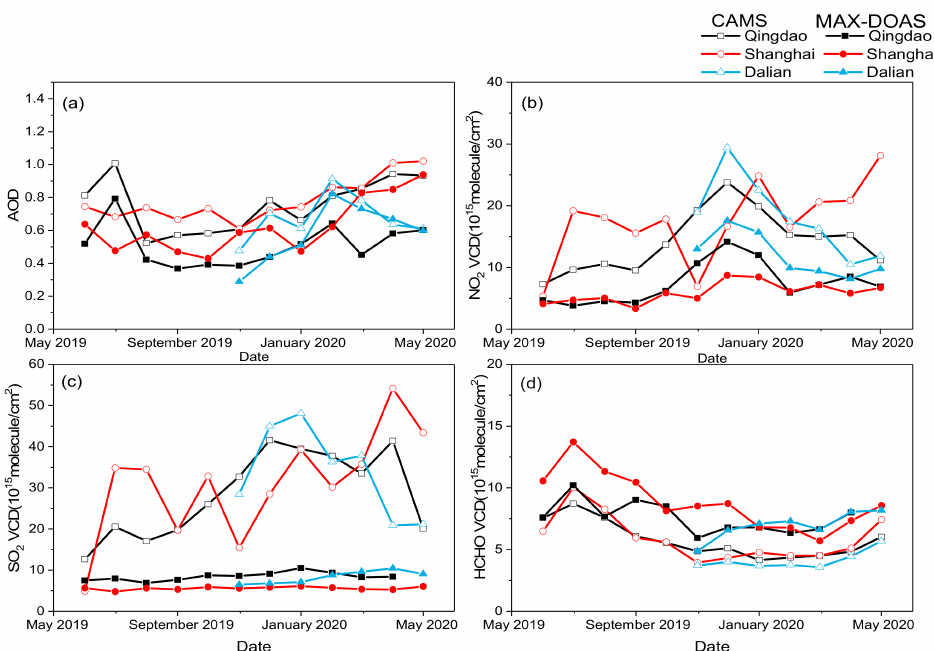
Figure 14. Monthly averaged AOD ( a ) and trace gas VCDs ( b – d ) derived from the coincident Coper- nicus Atmosphere Monitoring Service (CAMS) model and MAX-DOAS observations in